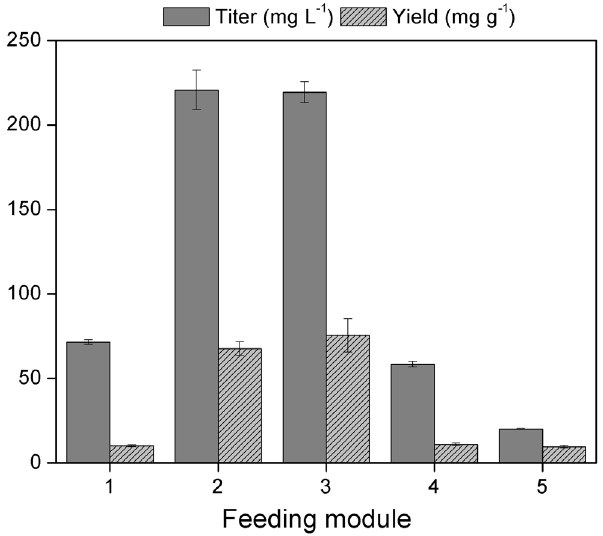
Figure 3. Isoprene titers and yields from different feeding modules. Module 1, EMP of strain FMIS 1; Module 2, EDP + PPP of strain FMIS 2; Module 3, EDP of strain FMIS 3, these three strains used glucose as carbon source. Module 4, PPP of strain FMIS 4; Module 5, Dahms pathway of strain FMIS 5, these two strains used D-xylose as carbon source. All strains are listed in Table S1 in File S1. A 160 mL serum bottle containing 40 mL of semi-defined medium, consisted of M9 salts, 5 g L 2 1 yeast extract, 10 g L 2 1 required carbon source and 1 mM thiamine pyrophosphate (TPP), was used for the cultivation of the strains for isoprene production.